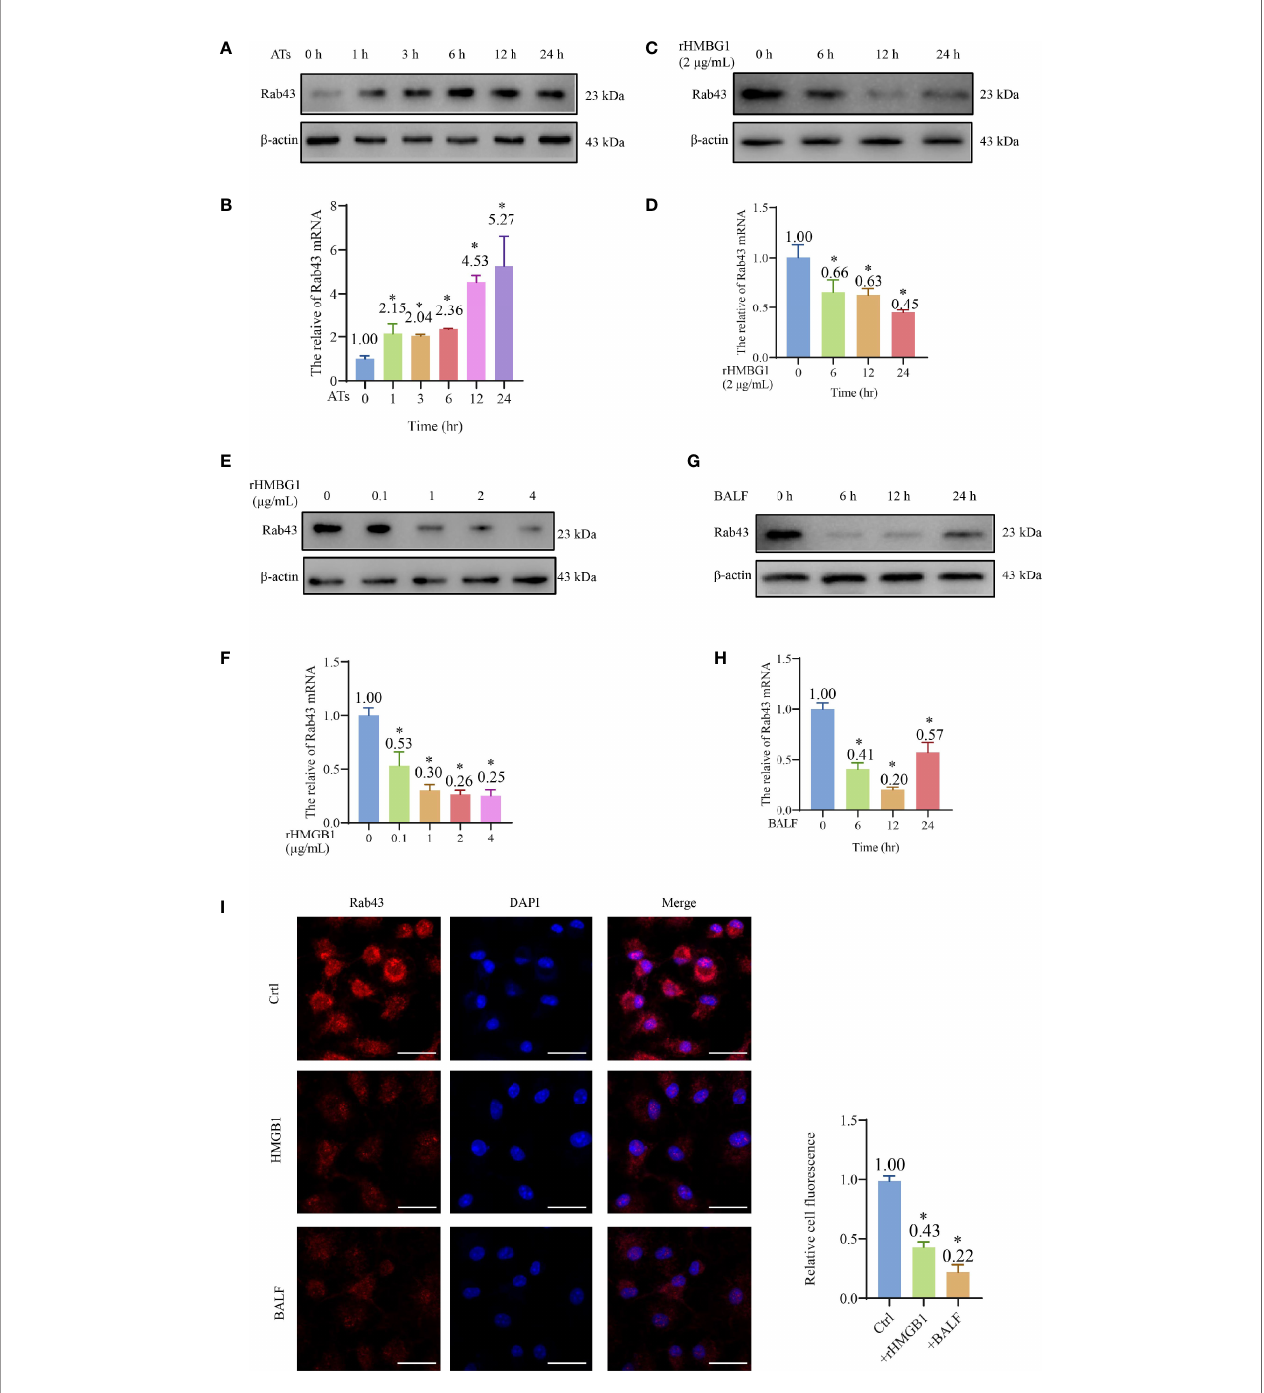
FIGURE 2 | HMGB1 suppressed the expression of Rab43. (A, B) Western blot and qPCR analyses of Rab43 mRNA and protein expression levels. The bone marrow-derived macrophages (BMDMs) were co-cultured with ATs (1:10) at the indicated time points (0, 1, 3, 6, 12, and 24 h). * P < 0.05 versus 0 h. (C – H) Western blot and qPCR analyses of Rab43 mRNA and protein levels. The BMDMs were treated with 2 m g/ml recombinant HMGB1 (rHMGB1) at indicated time points (0, 6, 12, and 24 h) (C, D) . The BMDMs were pretreated with 0.1, 1, 2, and 4 m g/ml rHMGB1 for 12 h (E, F) . C57BL/6 mice were treated with 5 mg/kg LPS for 24 h via i.t. injection and the BMDMs were treated with bronchoalveolar lavage fl uid (BALF) from the mice at indicated time points (0, 6, 12, and 24 h) (G, H) . * P < 0.05 versus 0 h. (I) The Rab43 protein expression in the BMDMs was determined after treatment with rHMGB1 and BALF for 12 h by immuno fl uorescence staining. The nuclei were stained with DAPI. Scale bars = 20 m m. * P < 0.05 versus the control